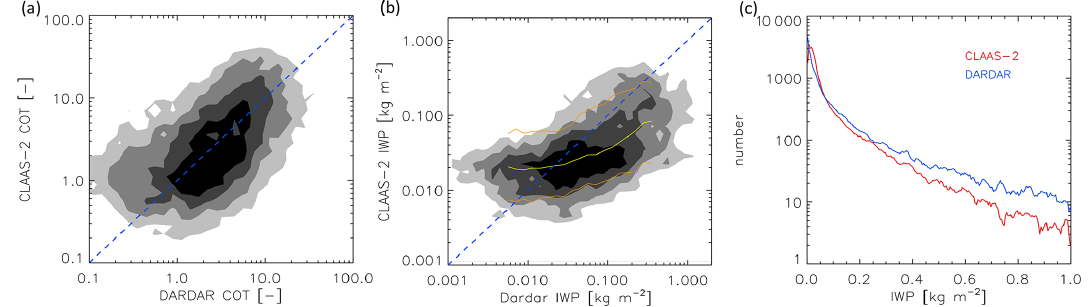
Figure 6. (a) Ice COT distribution comparing the collocated values retrieved from DARDAR and CLAAS-2. The blue dashed line is the 1 : 1 line and the gray scales indicate the regions enclosing 20, 40, 60 and 75% of all data points. (b) As in (a) for the IWP. The yellow line depicts the median and the orange lines represent the 16th and 84th percentiles of the CLAAS-2 distribution at the corresponding DARDAR